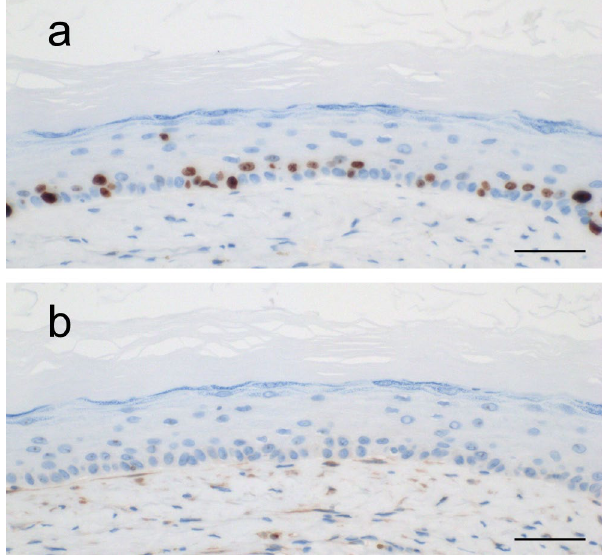
Fig. 2 Immunohistochemical analysis of multiple OOC. Representative immunohistochemical staining patterns of Ki-67 ( a ) and Bcl-2 ( b ) in multiple OOC. OOC, orthokeratinized odontogenic cysts. Scale bars: 50 μm in Figs. a and